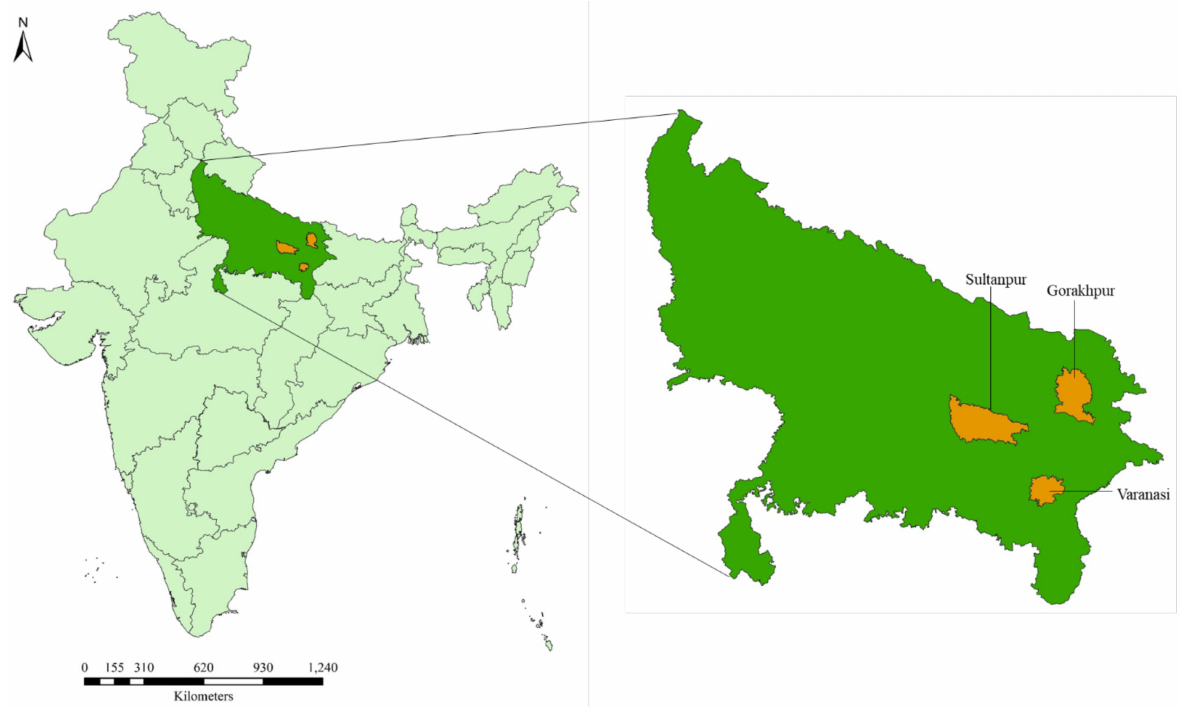
Figure 1. Study area: ES1-Varanasi (V), ES2-Sultanpur (S), and ES3-Gorakhpur (G), which fall under different agro-ecological subzones on the Indo-Gangetic Plain (IGP) of